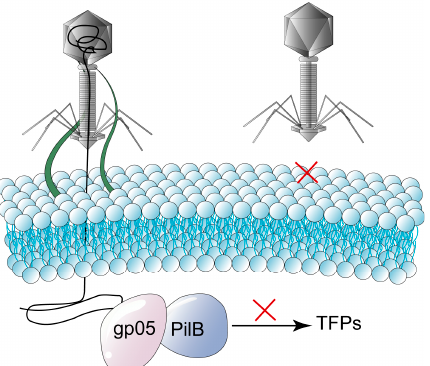
Figure 2. Bacteria hinder the phage’s DNA injection via superinfection exclusion (Sie) (the symbol red cross in the figure indicates that the adsorption of the phage is prevented). Phage D3112 encodes protein gp05, which inhibits the activity of PilB by interacting with PilB, affecting the assembly or function of TFPs and thereby preventing re-infection of host cells by phage MP22, which also uses P. aeruginosa TFPs as receptors.